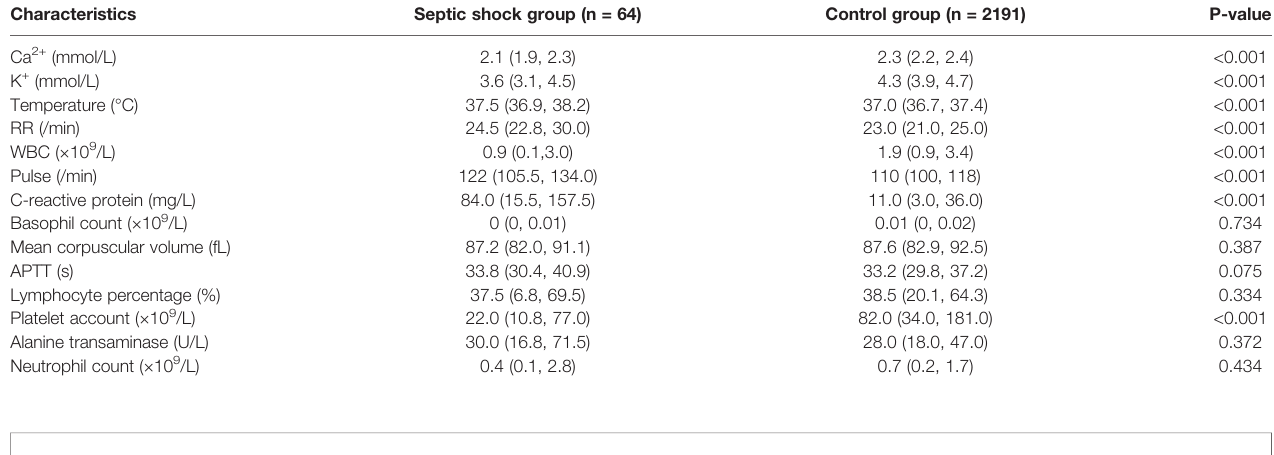
TABLE 2 | Characteristics between the groups at 24 h OBS point. Characteristics